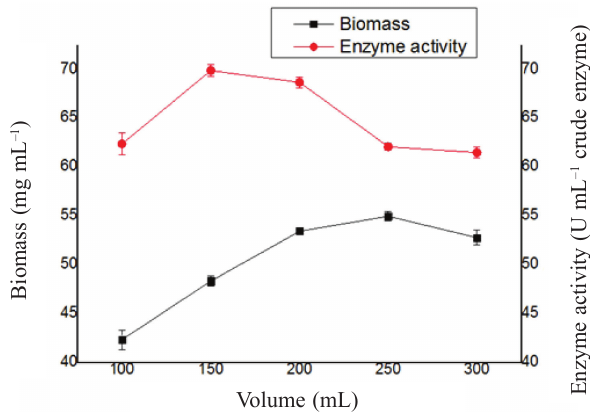
Fig. 4 – Effect of flask volume on enzyme fermentation per-